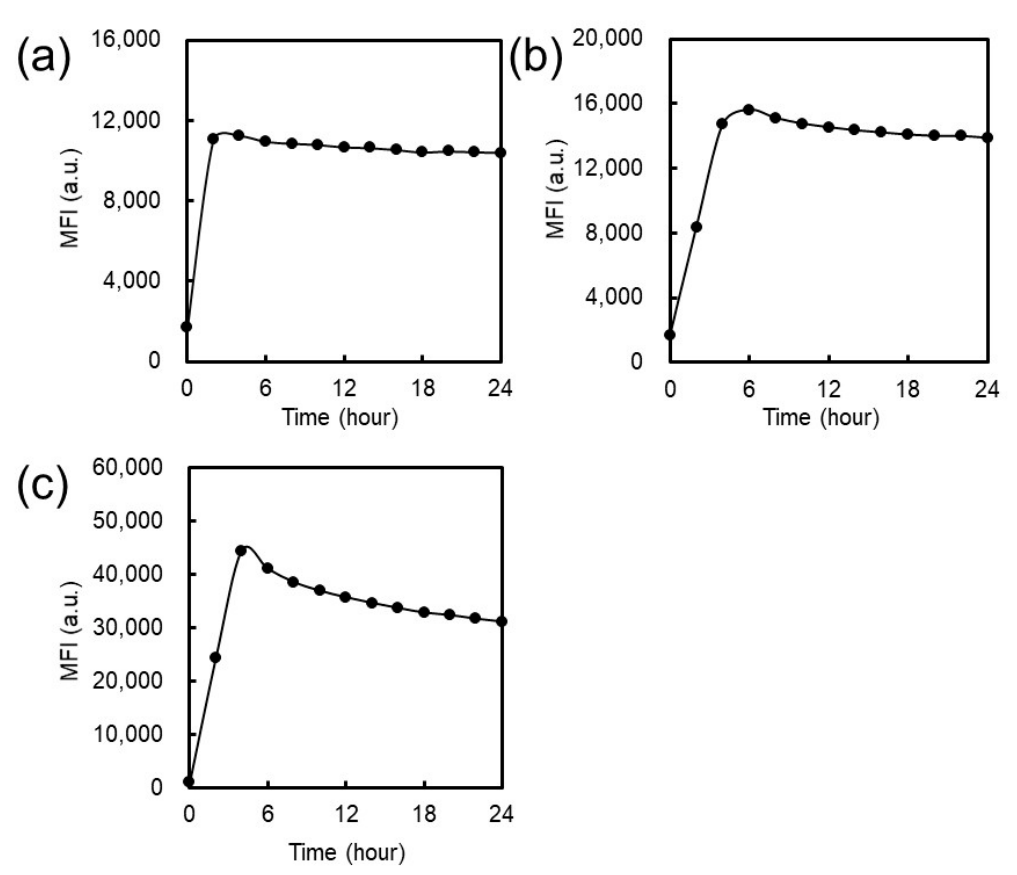
Figure 2. Time-dependent change in the ThT fluorescence intensity of solutions containing the ( a ) EG 6 peptide, ( b ) EG 12 peptide, and ( c ) EG 24 peptide when incubated at 37 °C.